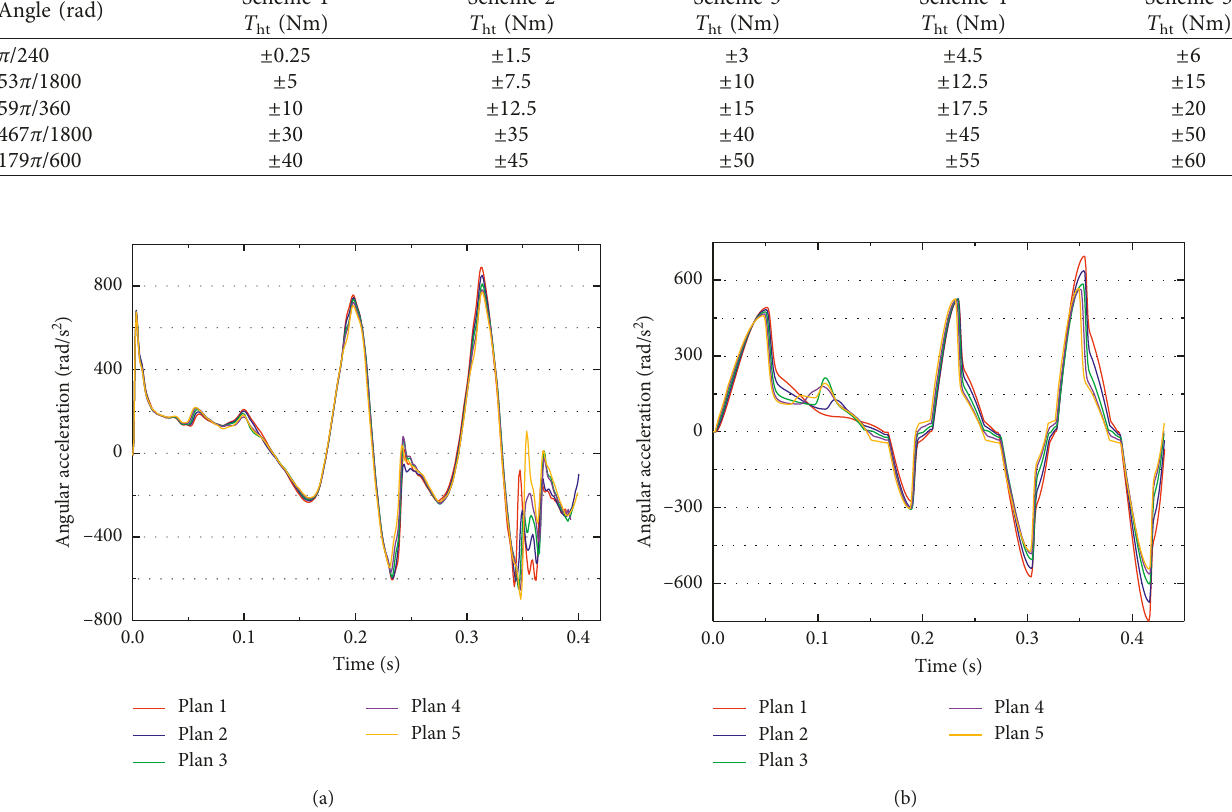
Figure 13: Angular acceleration under different damping schemes in Phase A. (a) The primary side result; (b) the secondary side result.